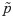
Sex-bias estimates from 1000 Genomes Project high-coverage whole genomes.Estimates of and 95% confidence intervals for the proportion of females from our method for the best-fitting demographic model for each population. Demographic models are defined in the main text. (A) Our method infers a constant proportion of females, p˜, for Yorubans (best demographic model: old growth), Punjabis (complex model), Southern Han Chinese (complex model), and Peruvians (bottleneck model). (B) Our method infers a changing proportion of females for Europeans (complex model) with a female bias outside bottleneck (p1˜, “non-bottleneck”) and a male bias during the bottleneck (p2˜, “bottleneck”).